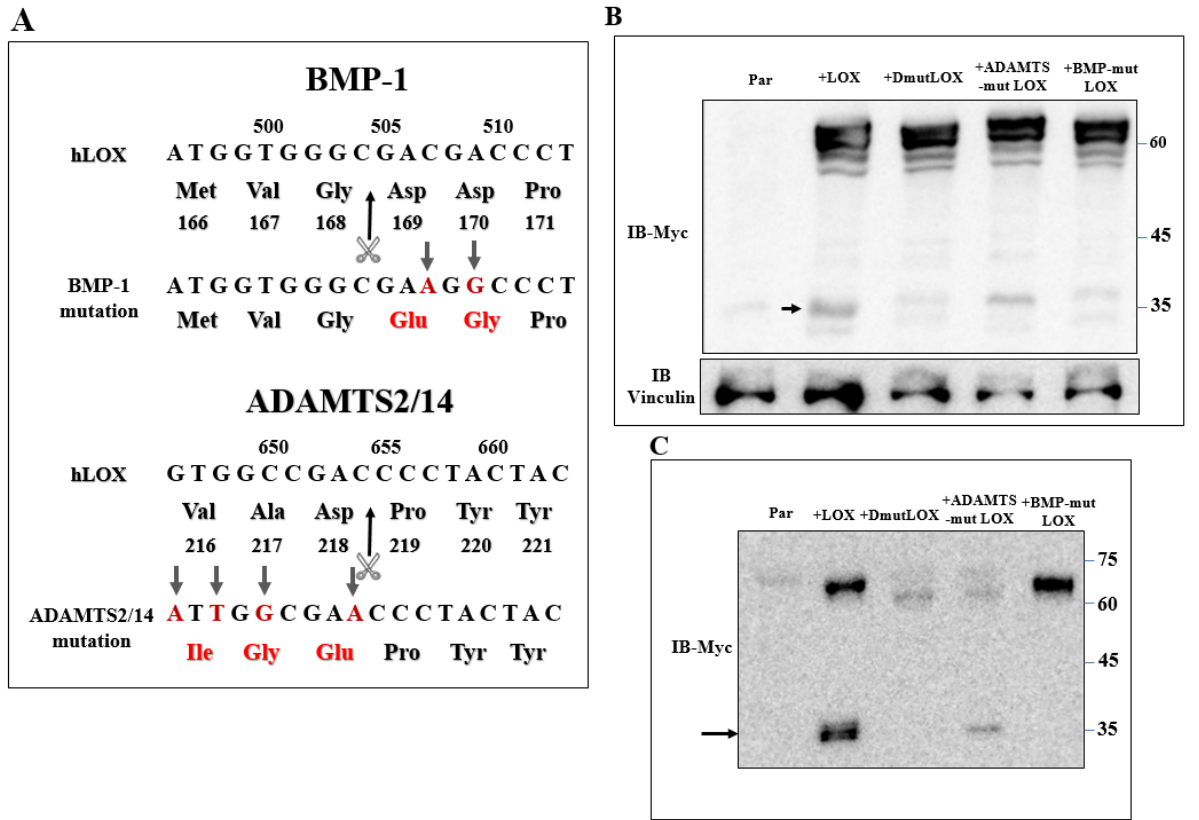
Figure 5. Generation of point-mutated LOX constructs. ( A ) A schematic illustration of the point mutations introduced into the LOX cDNA and protein sequence to generate the BMP-1 cleavage site mutant (BMPmut LOX), the ADAMTS2/14 cleavage site mutant (ADAMTSmut LOX) and the double mutant (DmutLOX) that contains both mutations. A myc epitope tag was added upstream of the stop codons of all constructs. Changed nucleotides and amino acids are indicated in red. The scissors mark the corresponding cleavage sites. Numbers above nucleotide sequences and under protein sequences indicate nucleotide numbers and amino-acid numbers, respectively. ( B ) Western blot analysis using anti-myc antibodies. LOX expression was assayed in cell lysates of HEK293 cells and HEK293 cells in which LOX and the various LOX mutants were expressed. Vinculin was used as a loading control. Cleaved LOX is marked by an arrow. ( C ) Western blot analysis using anti-myc antibodies of a conditioned medium derived from confluent HEK293 cells and HEK293 cells in which LOX and the various LOX mutants were expressed. Cleaved LOX is indicated by an arrow.